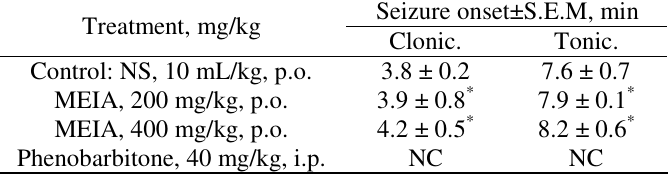
Table 5. Effect of MEIA on pentylenetetrazole-induced seizure in mice Seizure onset±S.E.M, min Treatment, mg/kg Clonic. Tonic. Control: NS, 10 mL/kg, p.o. MEIA, 200 mg/kg, p.o. Phenobarbitone, 40 mg/kg,